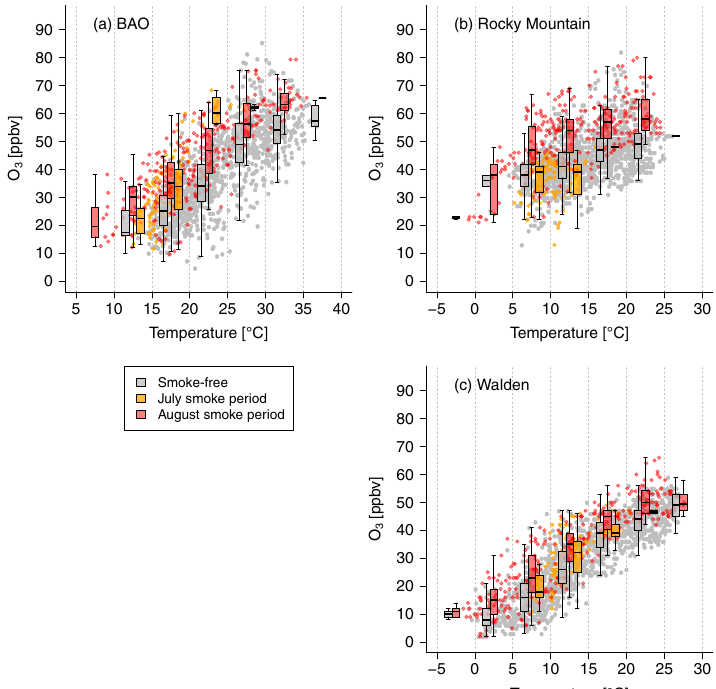
Figure 8. Hourly O 3 versus temperature for (a) BAO, (b) the Rocky Mountain National Park long-term monitoring site (ROMO), and (c) the Arapahoe National Wildlife Refuge long-term monitoring site near Walden, CO (WALD). Plotted here are all hourly data, with box plots showing standard percentiles of 5 ◦ C binned O 3 data as shown in Fig.